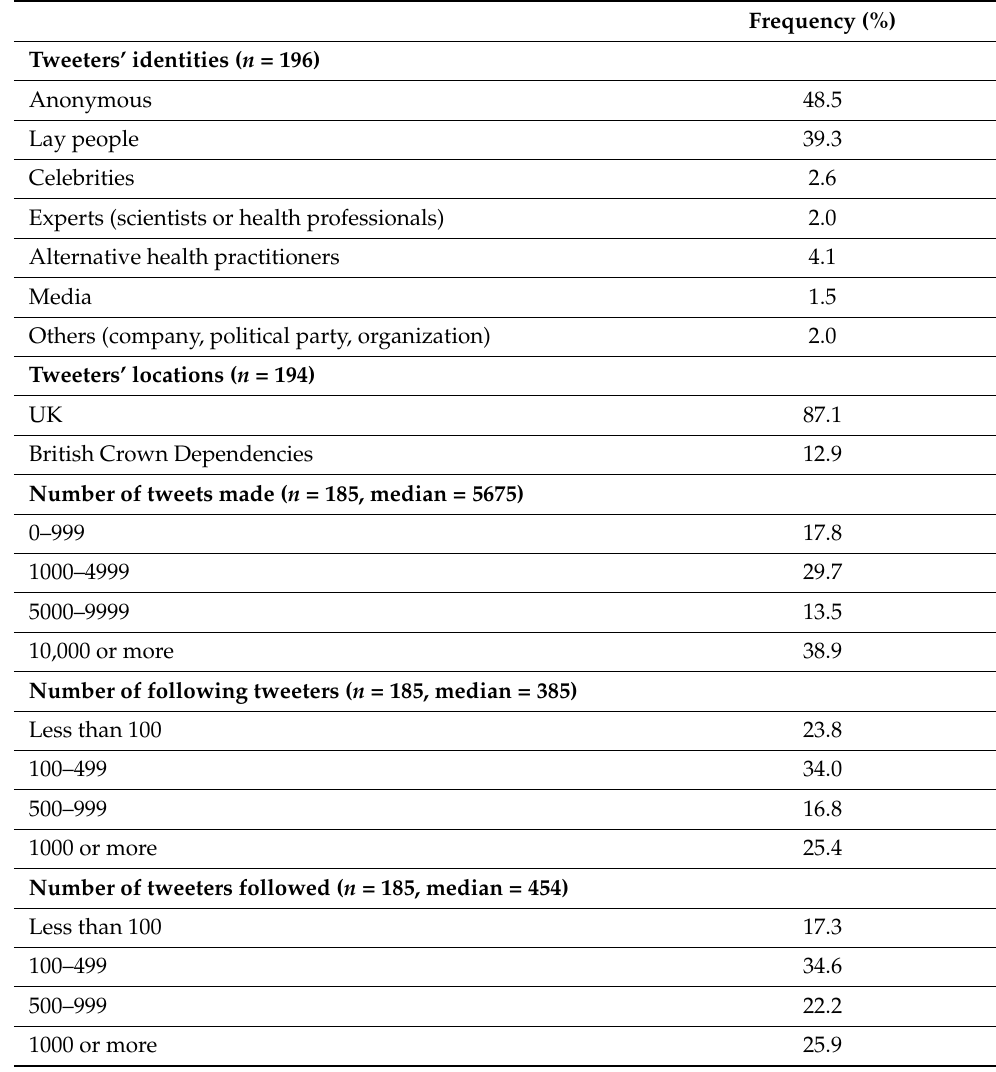
Table 1. Characteristics of anti-vaccine